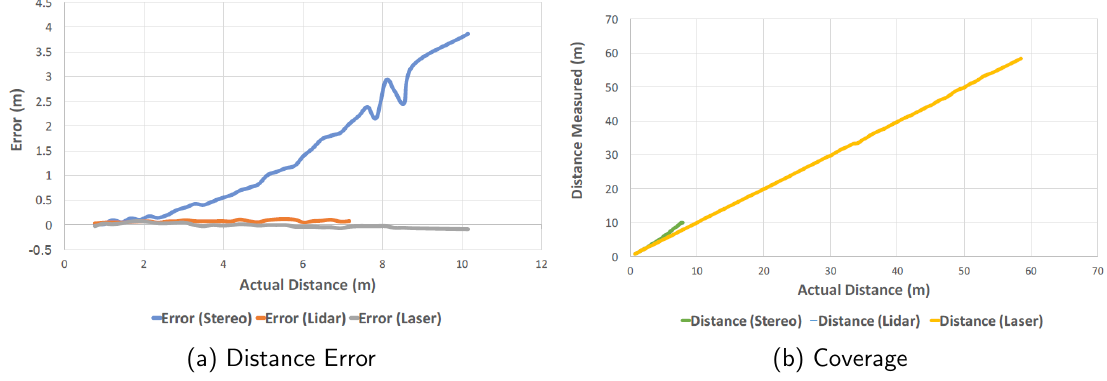
Figure 12. Ranging error and coverage of the Stereo, LiDAR and Laser